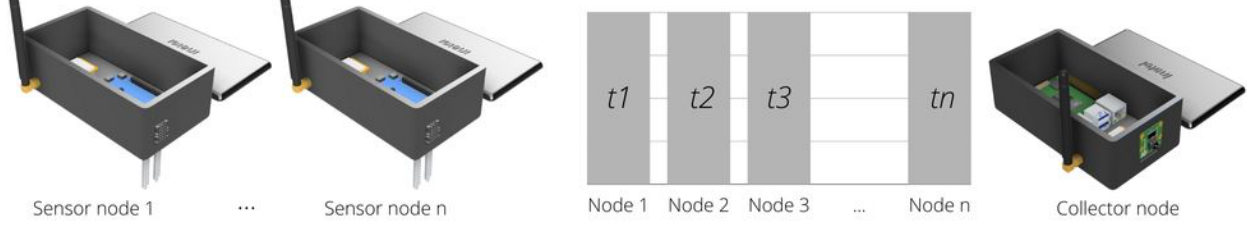
Figure 7. Multiplexing schema used with the IoT